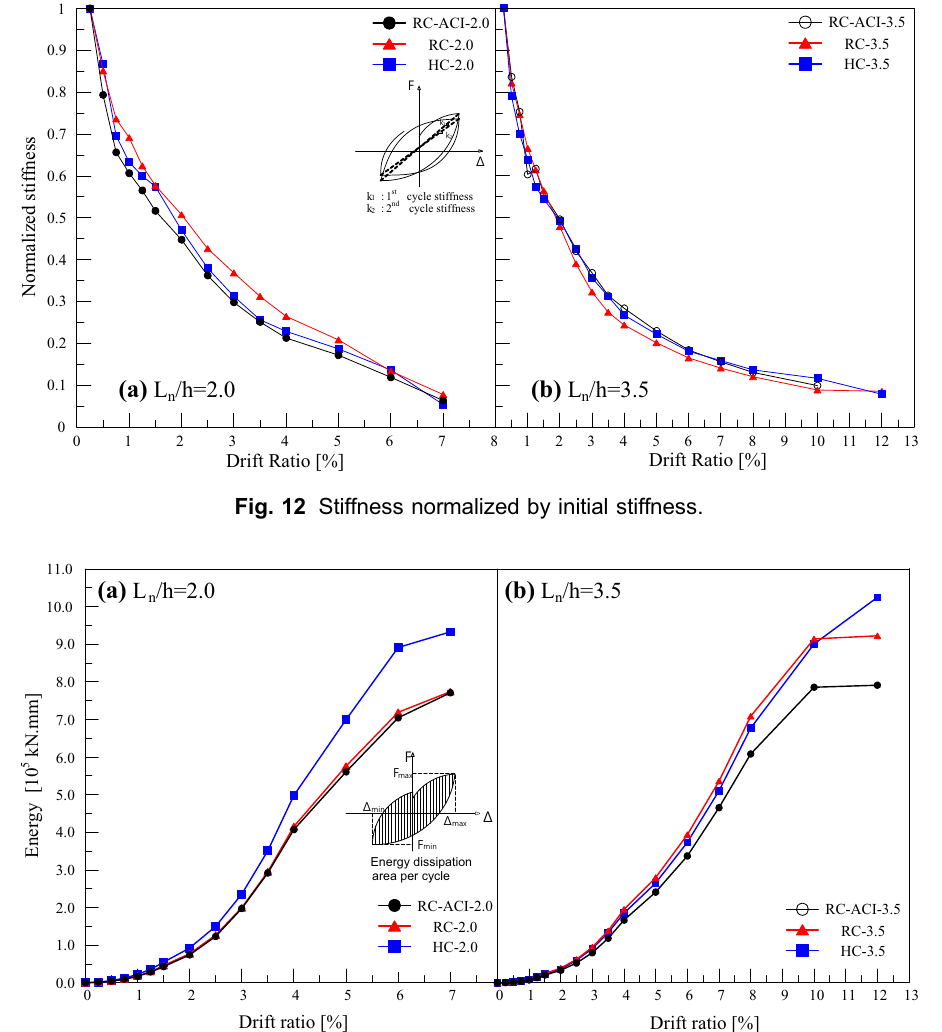
c þ c 1 2 c ¼ 2 Here, c and c are the angular changes in the two initially 1 2 90 (cid:3) angles of each shaded region (e.g., at points 2 and 3 in Fig. 5c). The angular changes were estimated by using the deformed lengths of the two initially right triangles (having a common hypotenuse, e.g., between points 1 and 4) formed